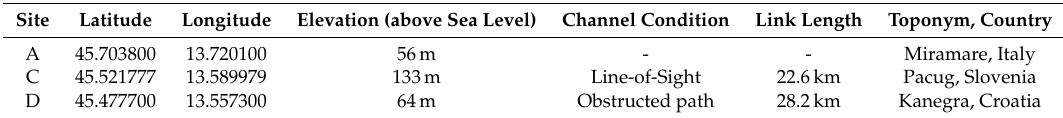
Table 1. Geographical details of the experimental